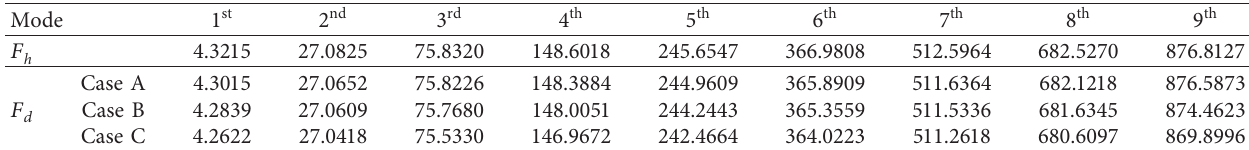
Table 2: First nine natural frequencies of the cantilever beam